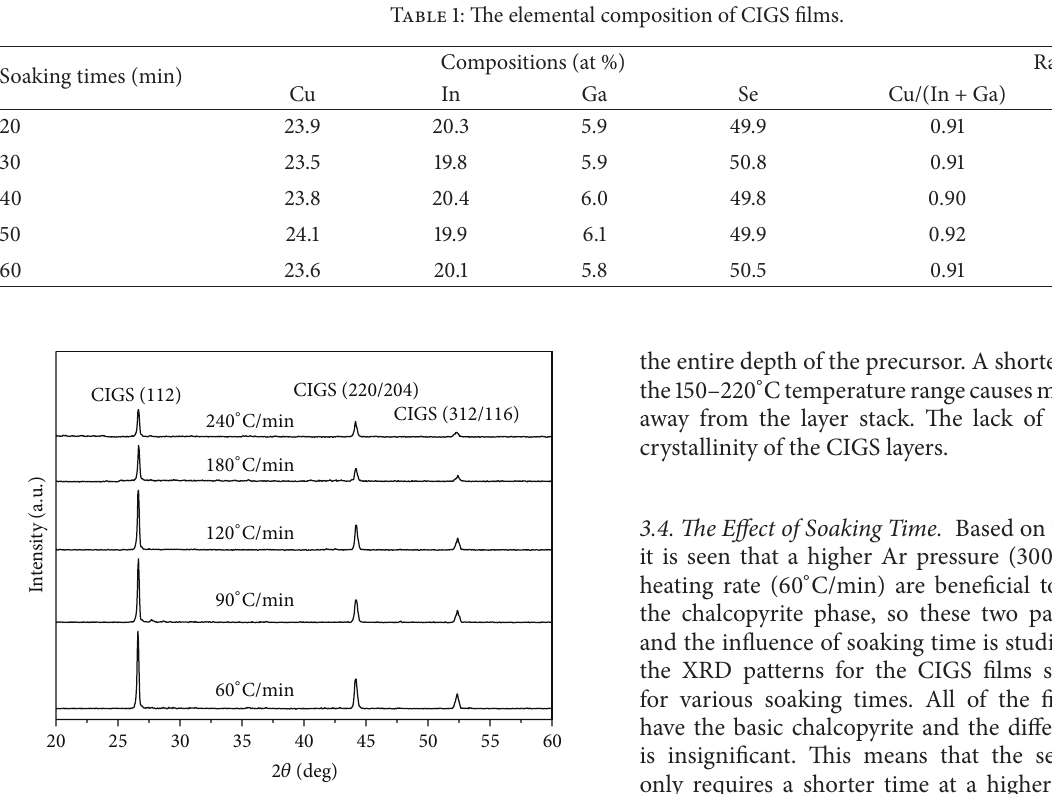
Figure 7: XRD patterns of the selenized CIGS films as a function of heating